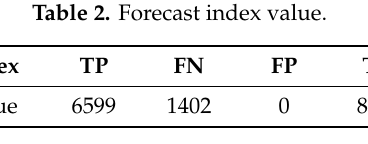
Figure 6. GLCM feature variance value comparison.